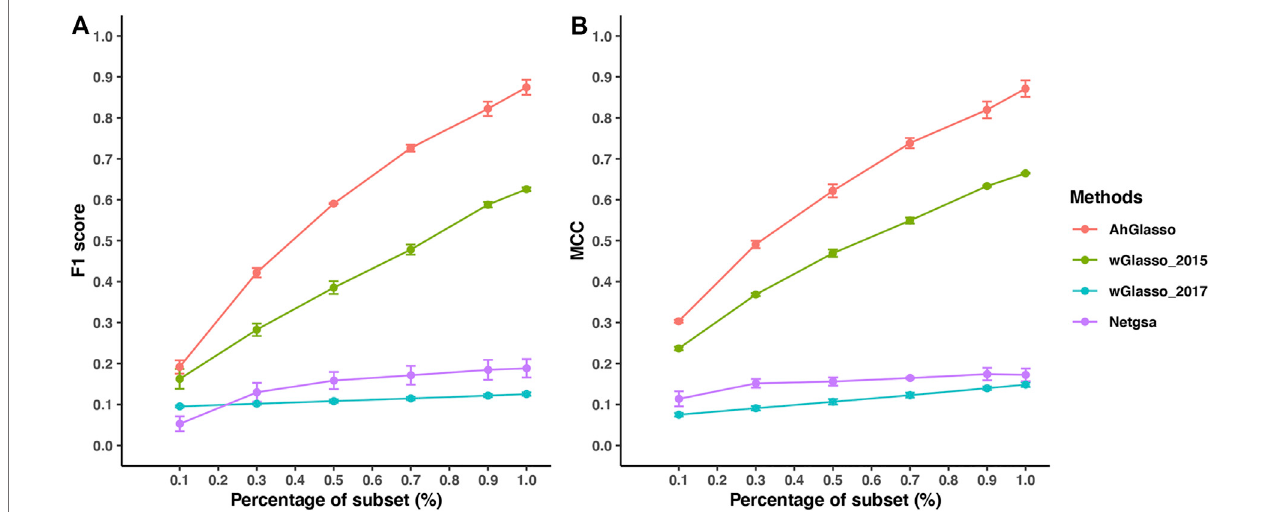
FIGURE 5 | Method performance comparisons with partially known prior information. The simulated protein network graph includes 1000 ( p ) nodes with fi xed samplesize( n (cid:1) 300).Thedensityofthesimulatedgraphisaround4 % .Thepriorinformationisasubsetofthetargettruenetwork.Avarietyofsubsetpercentagesofthe priornetwork were simulated as shown in X-axis. We estimated the true network topology byusing twoweighted graphical Lasso (wGlasso_2015 and wGlasso_2017), Netgsa, and the proposed AhGlasso methods. The F1 score (A) and MCC (B) were calculated based on the estimated network and true network. For each simulation setting, the simulations were repeated 5 times. The lines represent the mean scores for the simulated sample size and the error bars represent the standard error of the mean for each method.